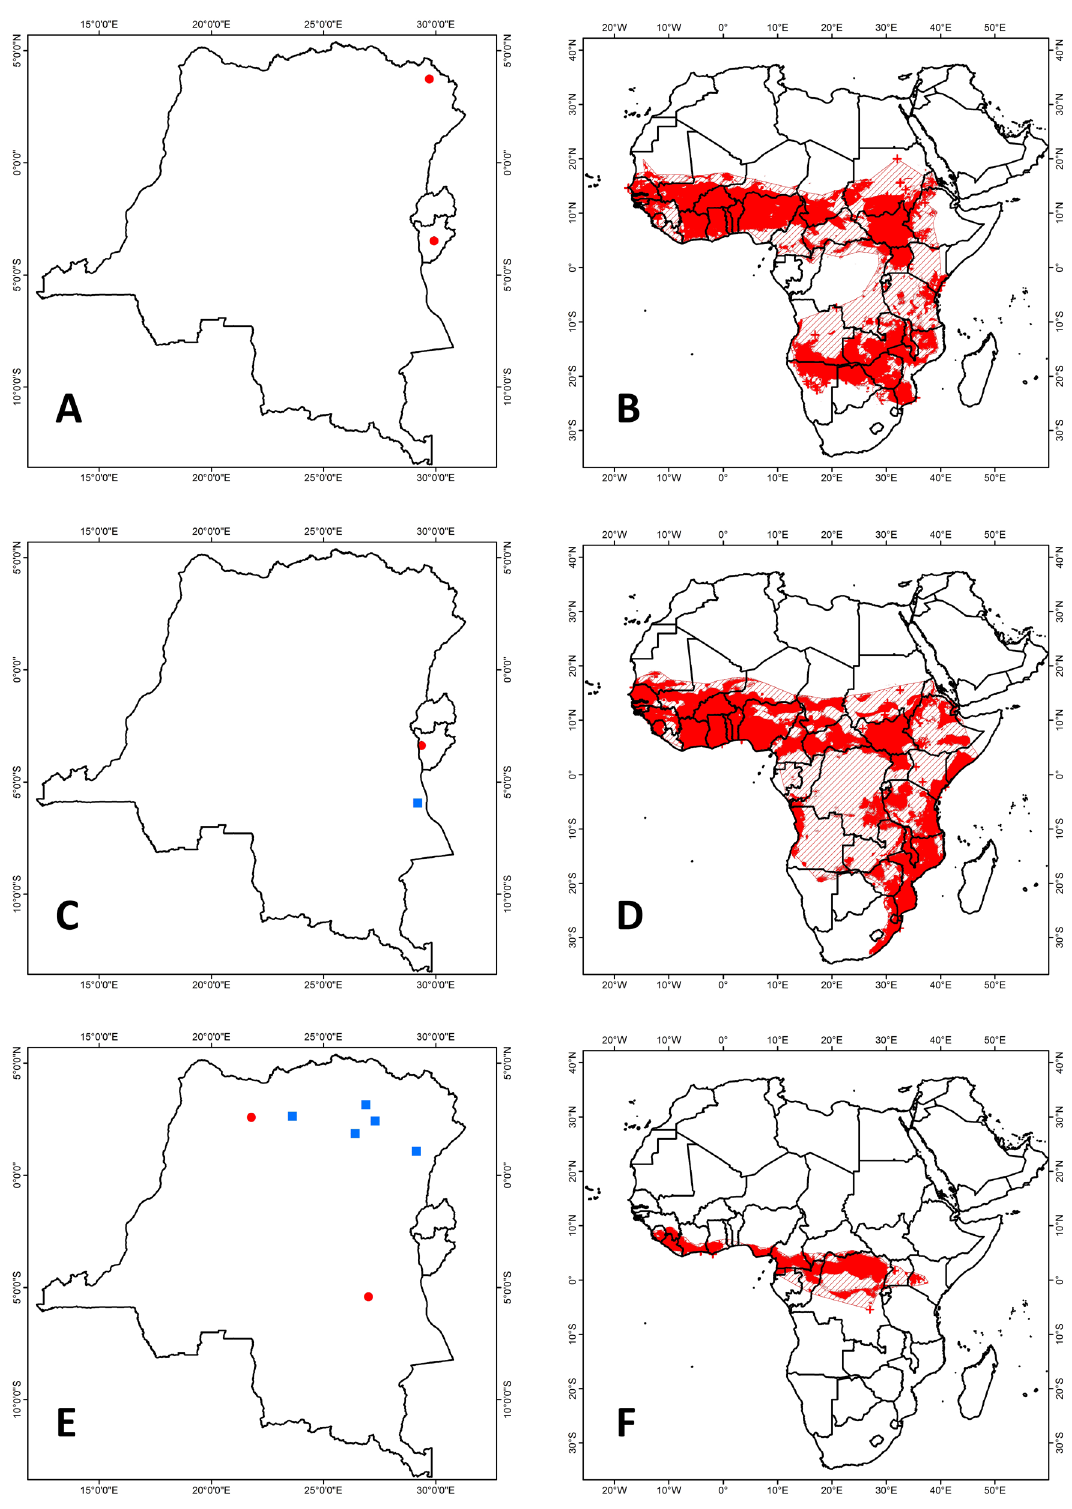
Fig. 37. Distribution maps. A–B . Scotophilus leucogaster (Cretzschmar, 1826). C–D .